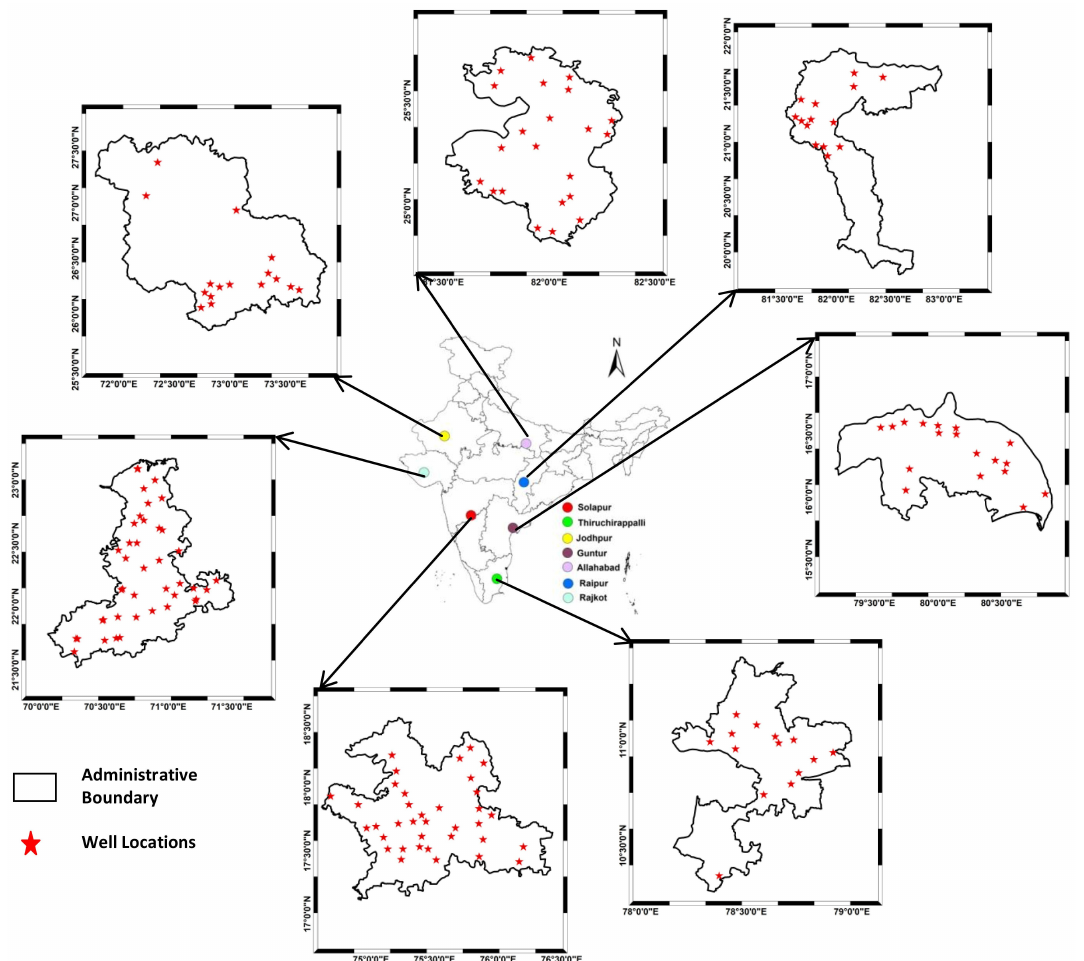
Figure 1. Study area map with the well locations in seven